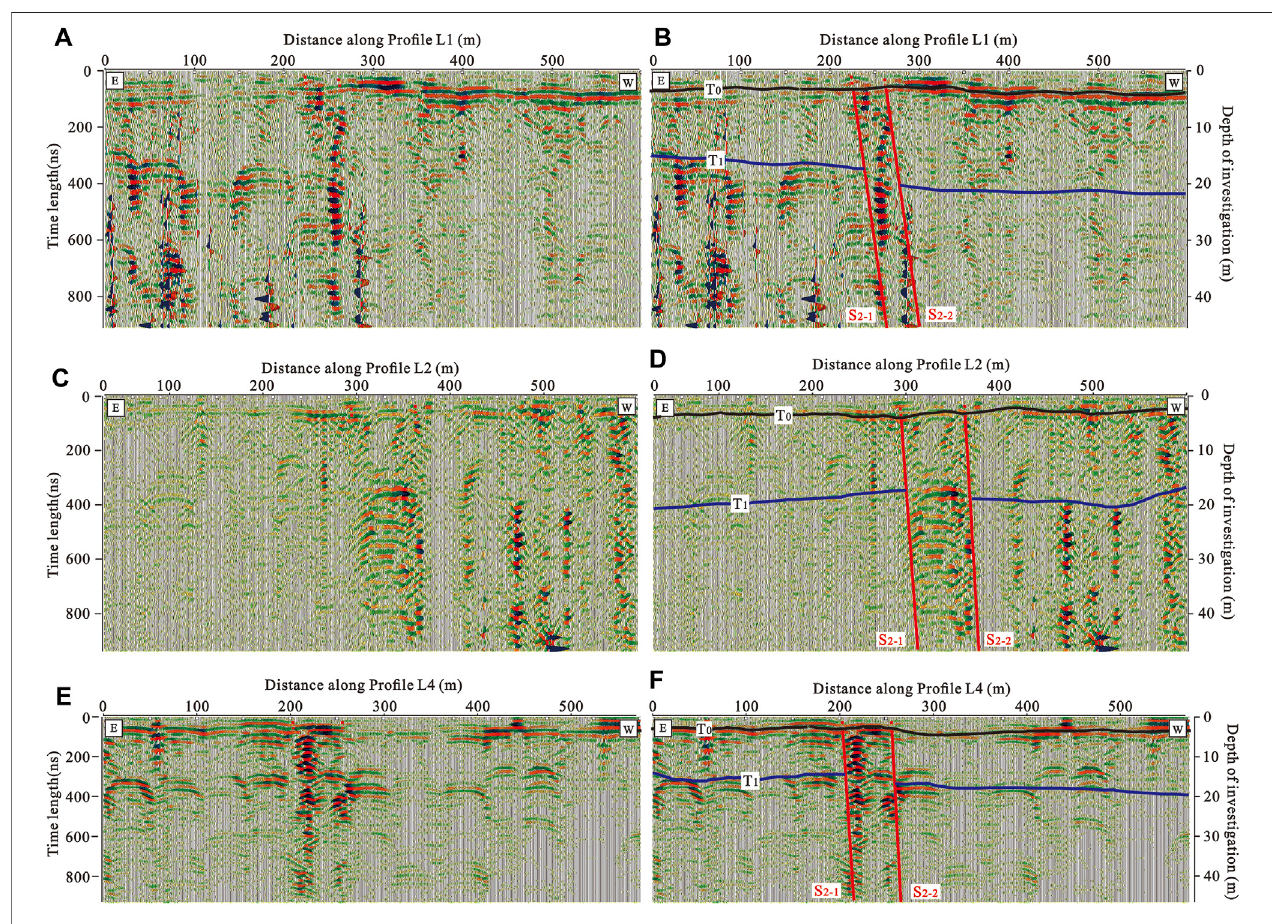
FIGURE8| GPRsectionsonthelineextendingfromthesouthernendofS 1 . (A,B) :SectionL1ofGPR; (C,D) :SectionL2ofGPR; (E,F) :SectionL4ofGPR;T 0 :The bottom of the Holocene deposits; T 1 : The bottom of the Quaternary sedimentary deposits. The locations of the three test lines are shown in Figure 5C .